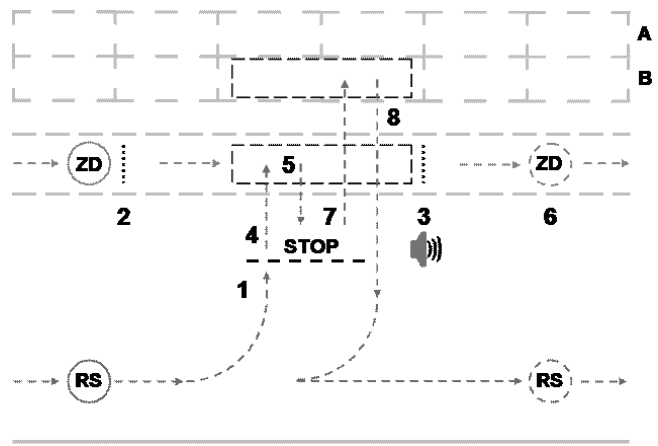
Figure 5. The scheme of a transportation cycle: from picking up of a large type A container from a tractor-trailer by a reach stacker to setting it aside in a prescribed storage area. Source: own work.